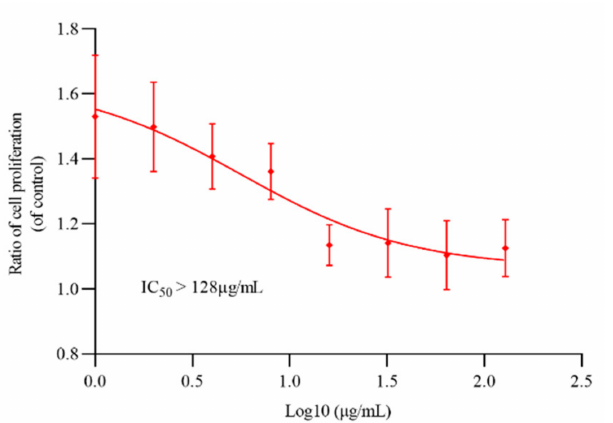
Figure 1. The cytotoxicity of oritavancin against THP-1 cells. The THP-1 cells were incubated with different concentrations of oritavancin for 72 h to determine its cytotoxicity. Data are expressed as the mean ± standard deviation (SD) of triplicates for each